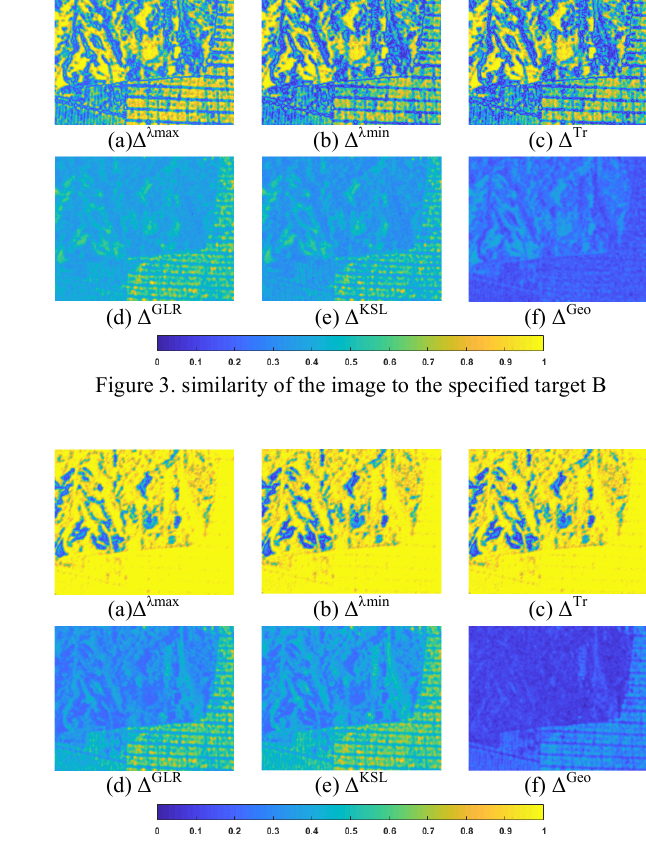
Figure 4. similarity of the image to the specified target